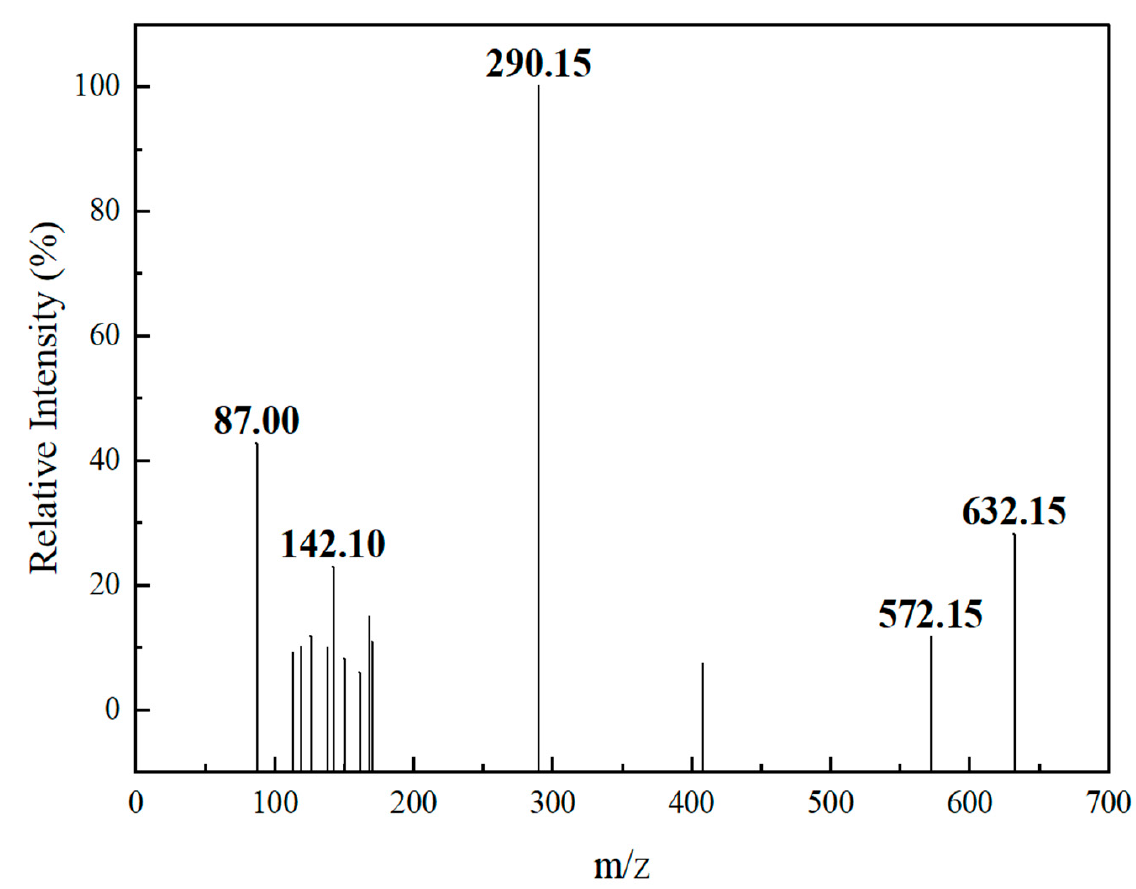
Table 2. Multi-reaction monitoring ion pairs and mass spectrometry conditions.